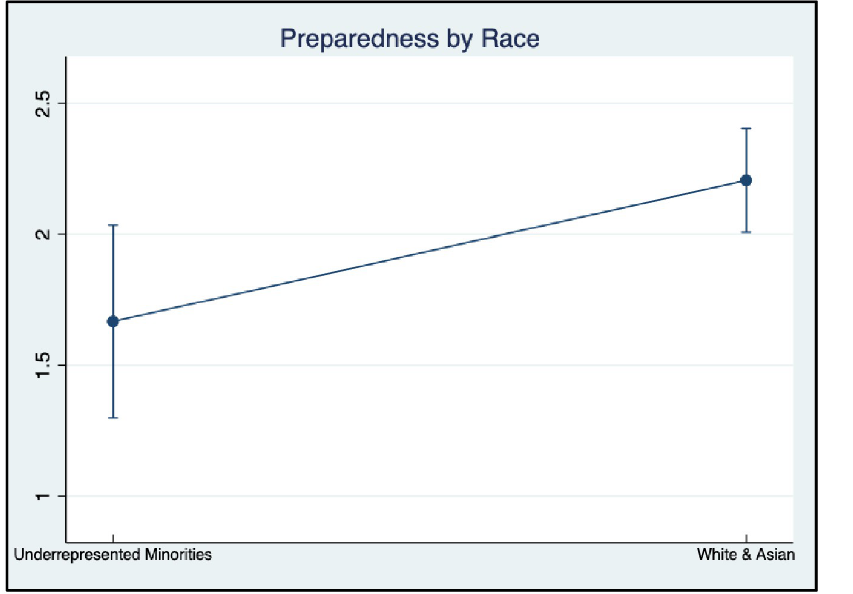
Fig 7. RDM preparedness by